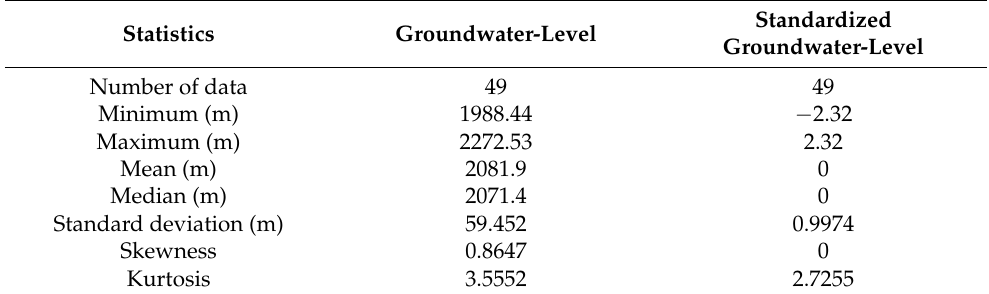
Table 1. Statistics of groundwater levels and standardized groundwater levels data.